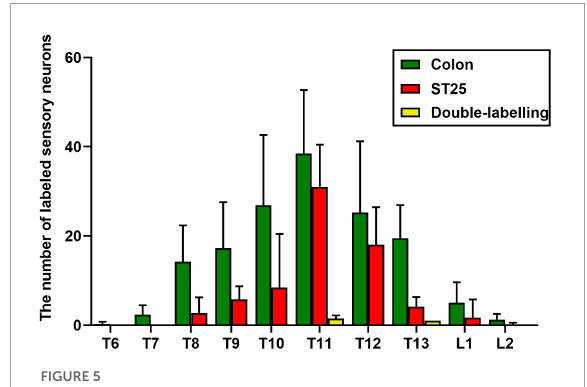
FIGURE5 The number of labeled sensory neurons in the thoracic (T) and lumbar (L) dorsal root ganglia (DRGs) (mean ± standard error, n =